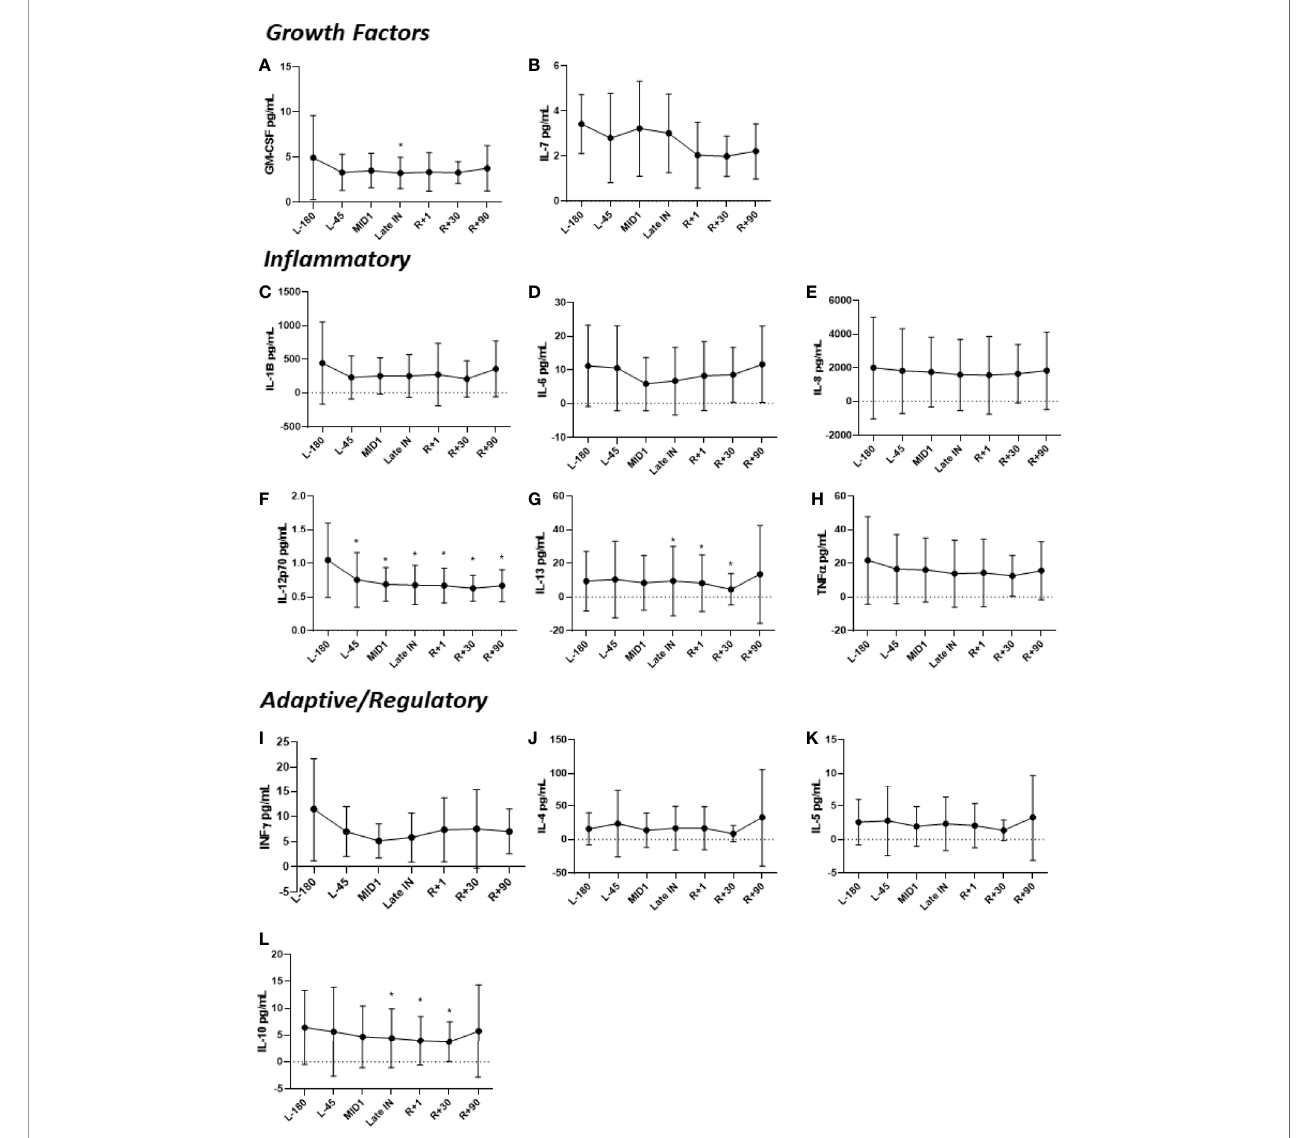
FIGURE 2 | Concentrations of salivary (A) GM-CSF, (B) IL-7, (C) IL-1 b , (D) IL-6, (E) IL-8, (F) IL-12p70, (G) IL-13, (H) TNF a , (I) IFN g , (J) IL-4, (K) IL-5, and (L) IL-10 before, during and after space fl ight. Data are presented in mean± SD. Saliva was collected from crewmembers on 5 consecutive days at the indicated timepoints. Means were determined by grouping pre fl ight, in- fl ight and post fl ight data. Signi fi cance was evaluated via a Student ’ s t test by comparing all other data points to L-180 baseline data. Signi fi cant differences (P ≤ 0.05) are indicated